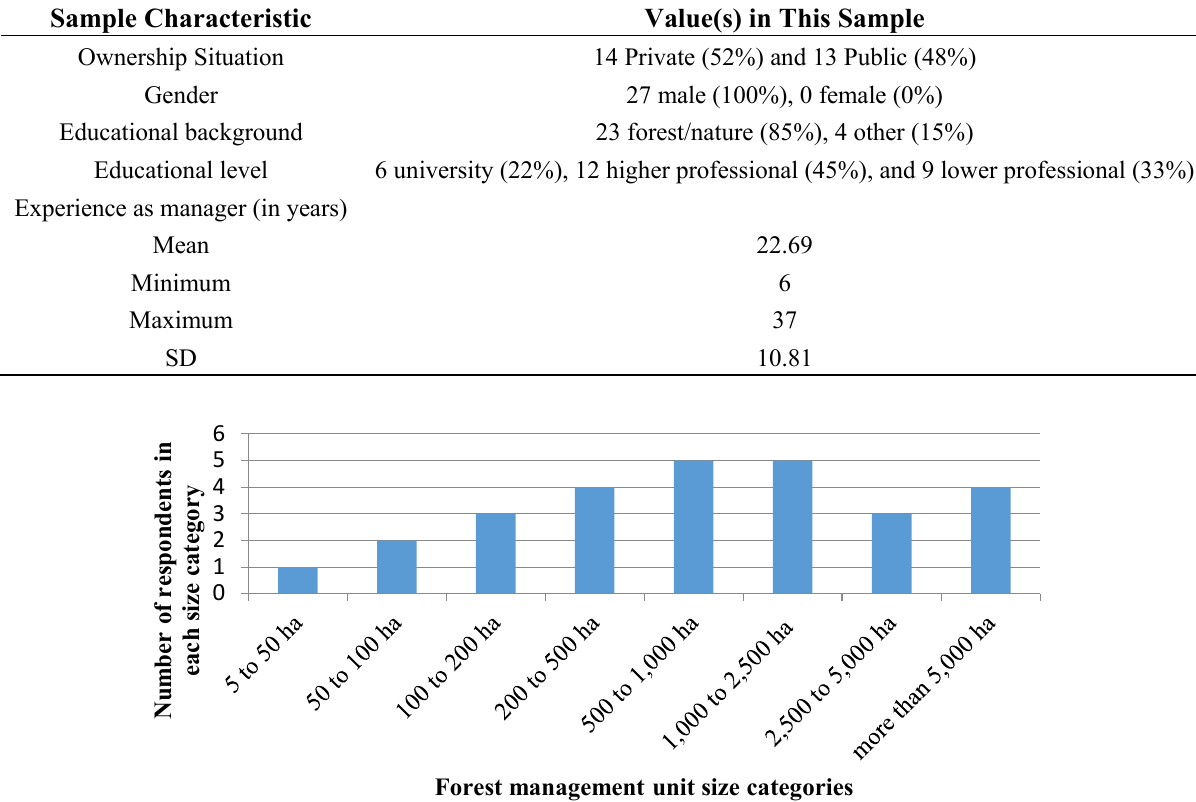
Figure 3. Distribution of the sample of forest managers based on the size of forest management unit they manage ( N =